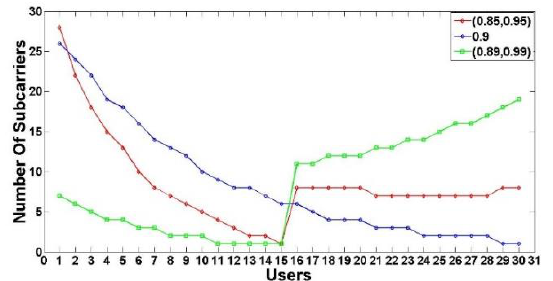
Fig. 2. Subcarriers allocation under 3 different scenarios: i) common δ=0.9, ii-a) δ I =0.85, δ II =0.95 and ii-b) δ I =0.89, δ II =0.99.